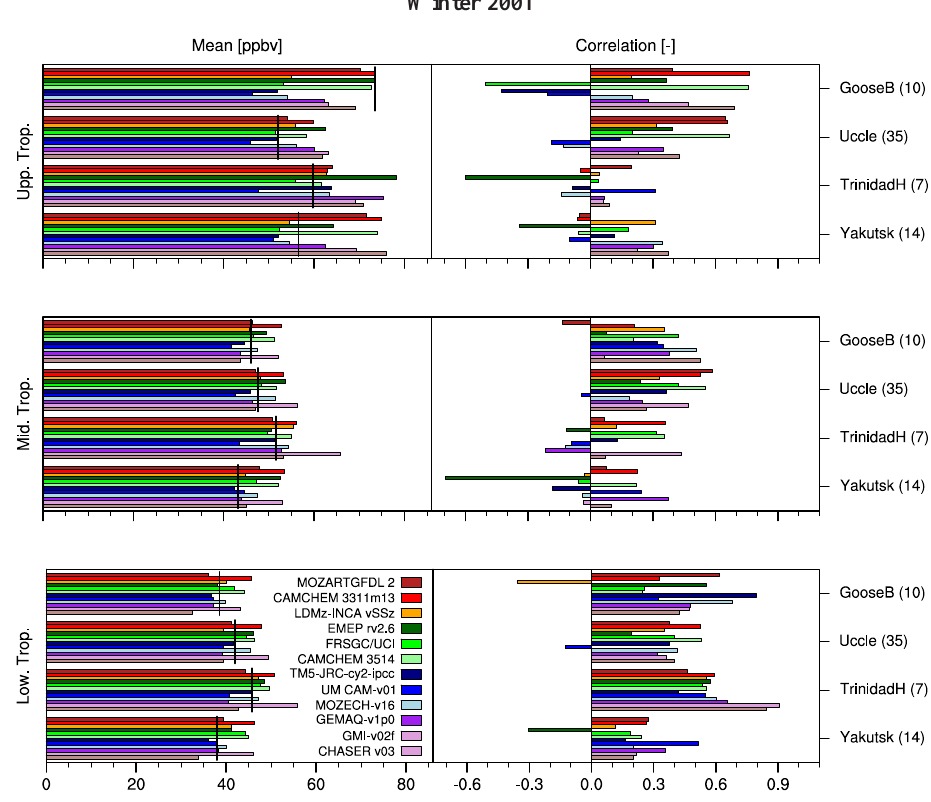
Fig. 3: Measured and model-calculated ozone (ppb) in winter (January, February, December) for the lower troposphere (900 - 700hPa), middle troposphere (700 - 500hPa) and upper troposphere (500 - 300hPa) for the selected ozonesonde sites. Concentrations to the left (solid lines crossing the model calculations are measurements), correlations to the right. The numbers behind the site name refer to the number of soundings available for comparison in Winter. GooseB. is short for Goose Bay, TrinidadH is short for Trinidad Head.